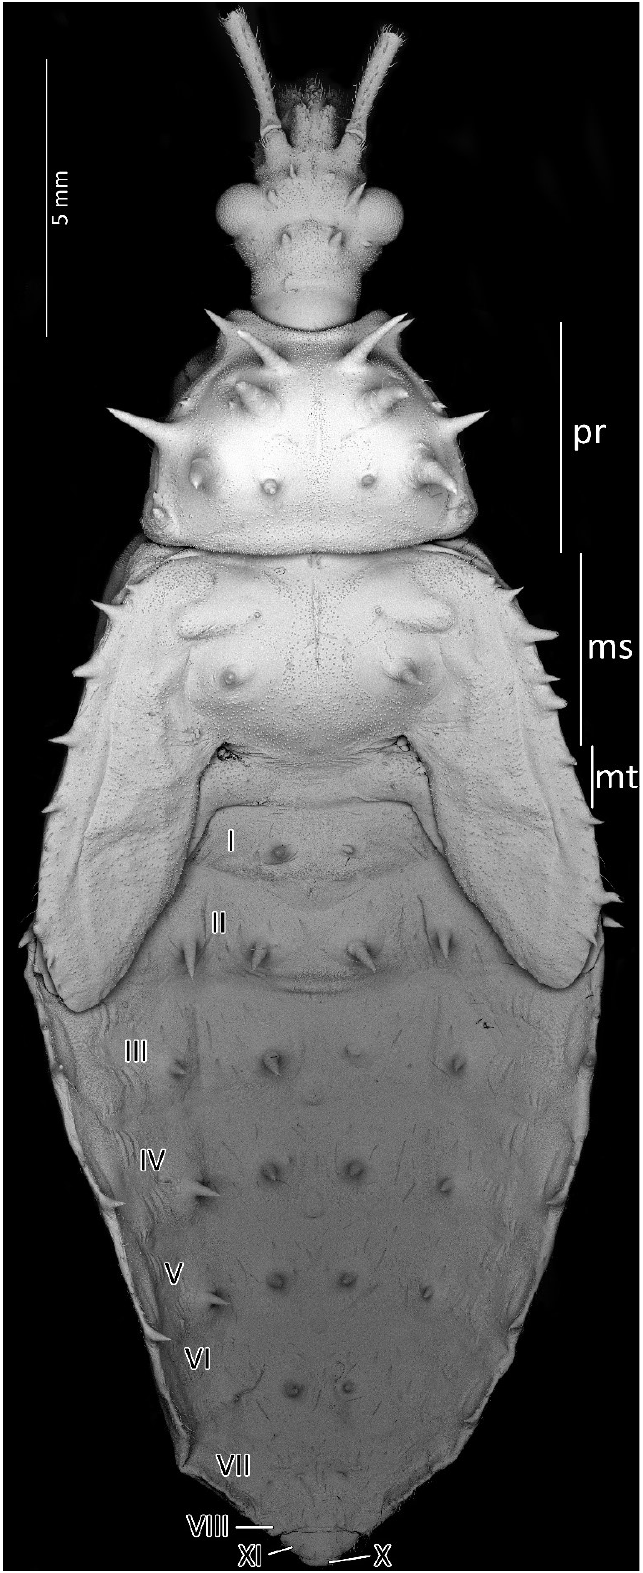
Figure 14. Dorsal habitus of the fifth instar of Psyttala horrida (Stål, 1865), detailed SEM view. ms — mesonotum; mt —metanotum; pr —pronotum; I – X —abdominal segments. Measurements (in mm): Body length 28.1–30.55; maximum width of abdomen 10.7– 11.25; head length 5.05–5.46; head width 2.7–3.0; length of anteocular portion 2.5–2.9; length of postocular portion 1.8–2.05; length of synthlipsis 1.75–1.85; length of antennal